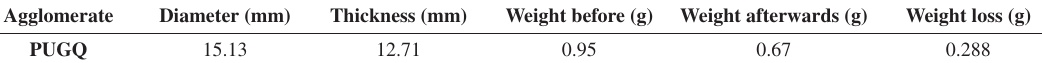
Table 5. Loss due to abrasion of the PUGQ agglomerate.